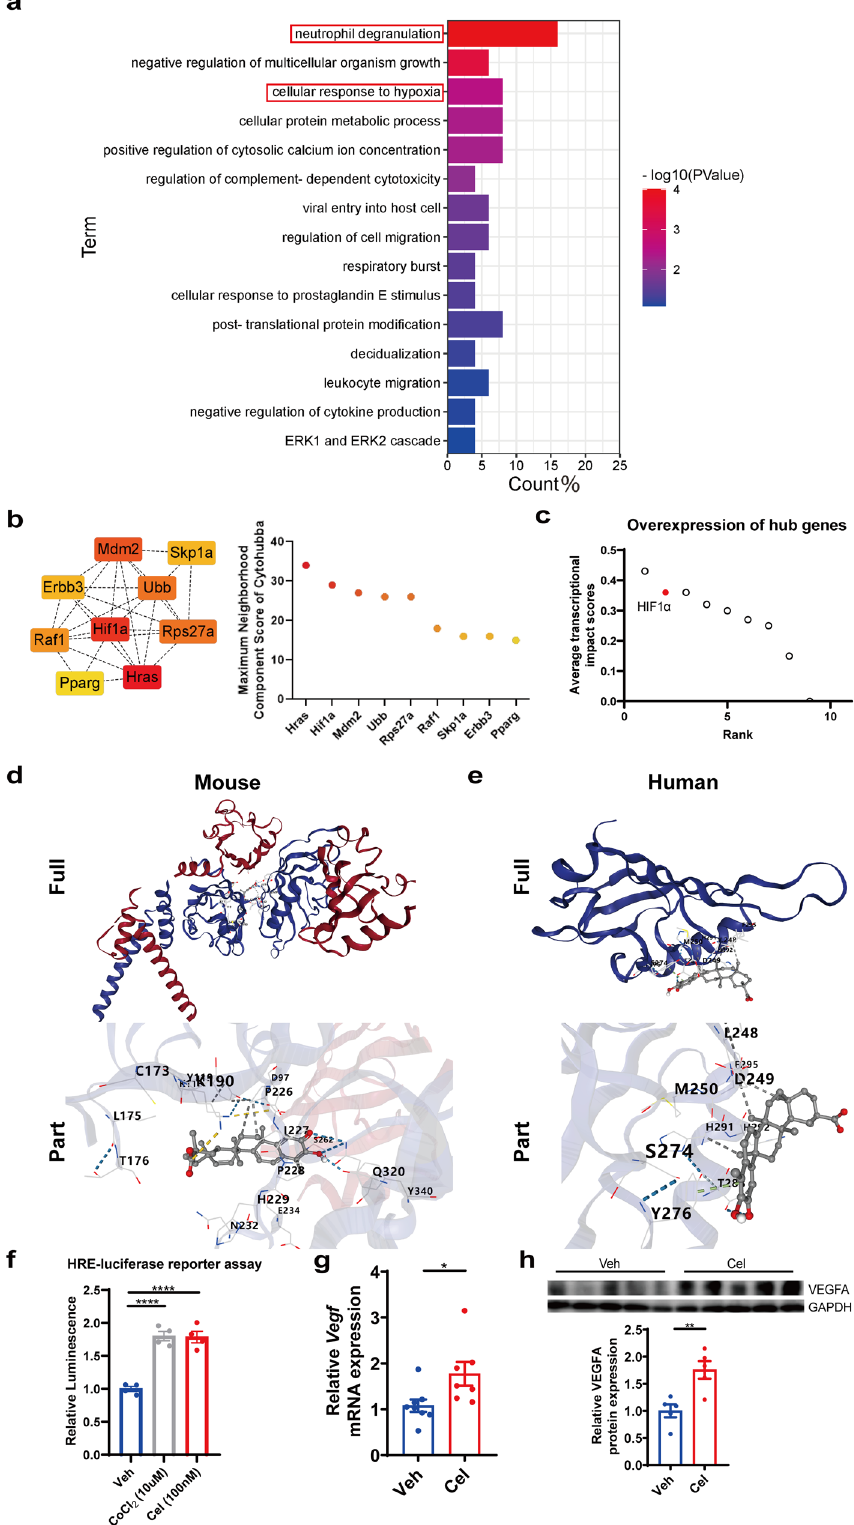
Fig. 7 Celastrol activated HIF1 α signaling. a GO analysis of celastrol-regulated pathways from GSE119291. b , c The top 9 celastrol-regulated hub genes ranked by Maximum Neighborhood Component scores of Cytoscape and CMap average transcriptional impact scores. d , e In silico molecular docking results of celastrol with mouse HIF1 α protein in ( d ) and human HIF1 α protein in ( e ). f Effect of 24 h celastrol treatment on transcriptional activity of HIF1 α (one-way ANOVA, n = 4, **** p < 0.0001). g , h Celastrol-regulated hepatic mRNA and protein expressions of VEGF (Student ’ s t-test, n = 5 – 8, * p < 0.05, ** p < 0.01). Data were expressed as mean ±